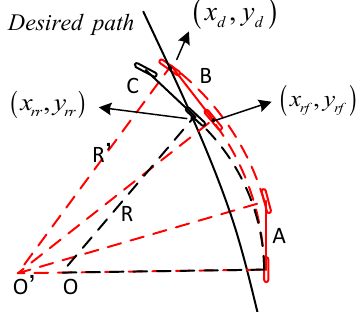
Figure 7. Pure pursuit control with rear and front axle references. is the circle center and ' R is the radius of the arc.